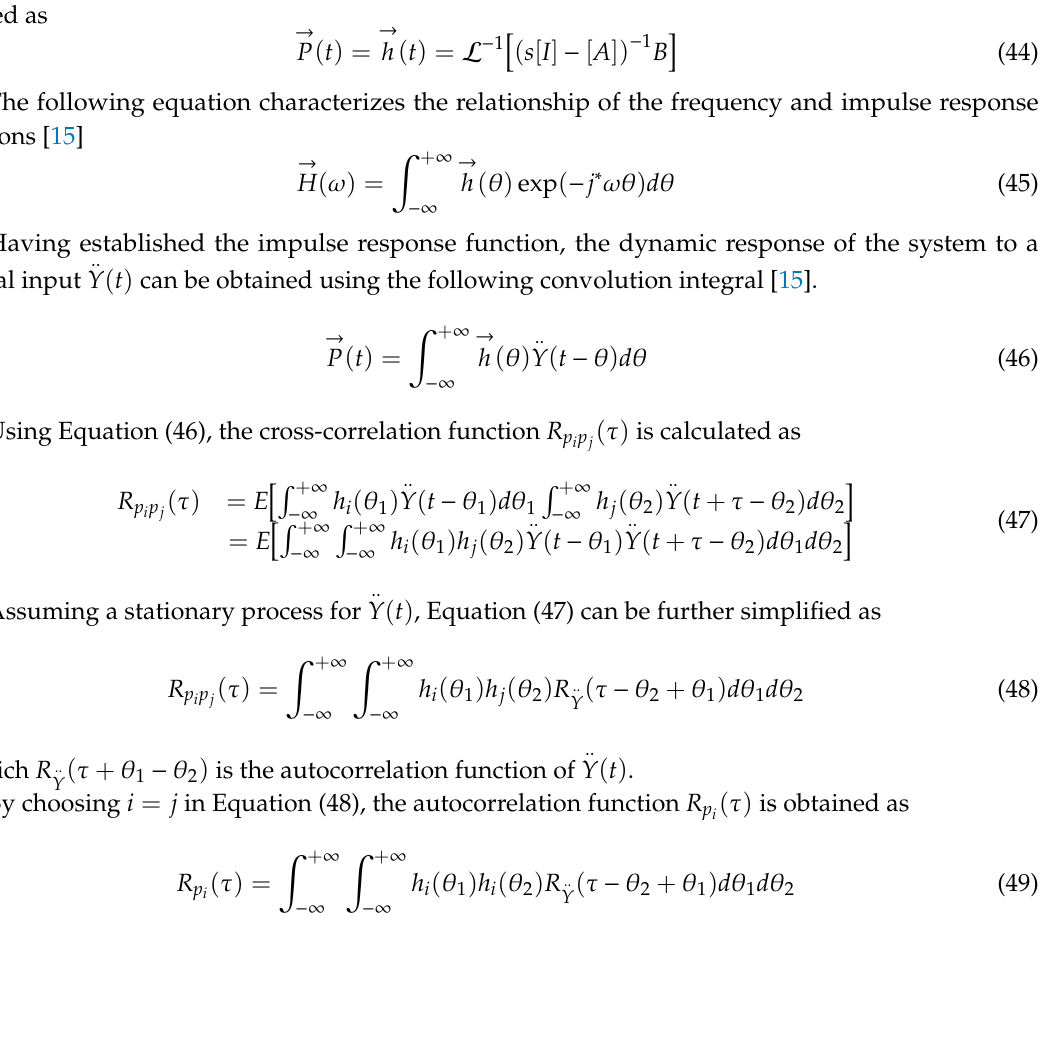
Figure 7. Frequency response curves of v 1 and v 2 due to harmonic base